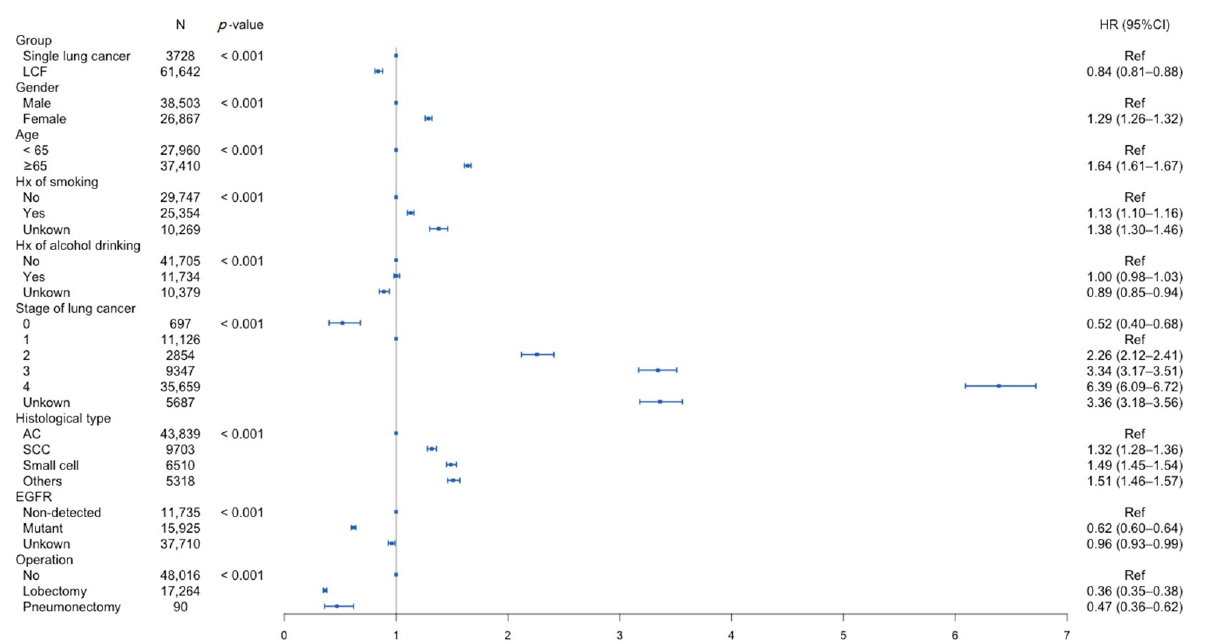
Figure 2. Multivariate analysis of overall survival in patients with single lung cancer and lung cancer first (LCF). AC: adenocarcinoma; EGFR: epidermal growth factor receptor; SCC: squamous cell carcinoma.